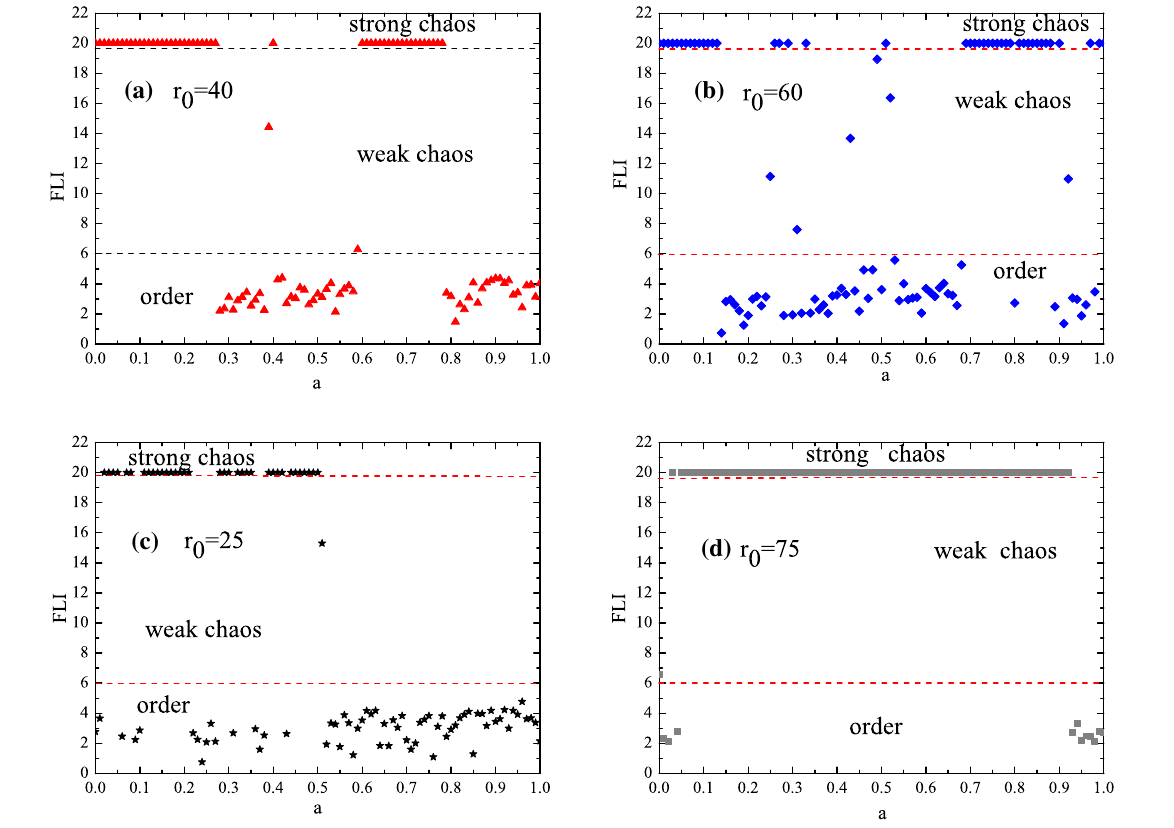
Fig. 6 Same as Fig. 5, but the dependence of the values of FLIs on the black hole spin a . Here, β = 0 .